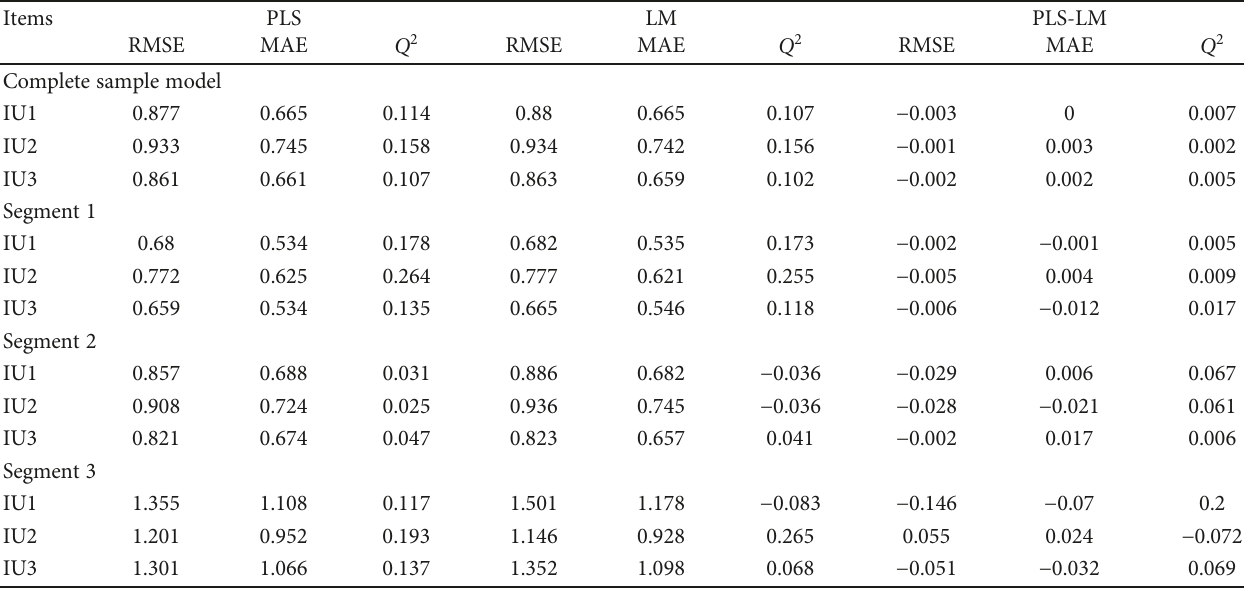
Table 14: PLS predict assessment.